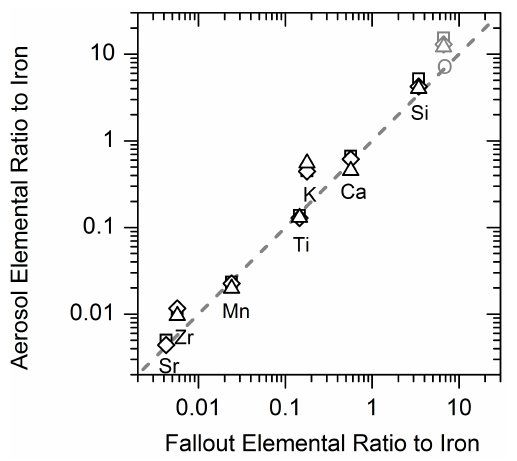
Fig. 3. Elemental ratio to iron in three aerosol samples (shown by different symbols) collected by the CARIBIC platform vs. fall out sample (SRG 5a, Sigmundsson et al., 2010). The dashed line in- dicates equal ratio. The oxygen content in the fallout sample is not measured and therefore indicated by grey symbols (see text for futher